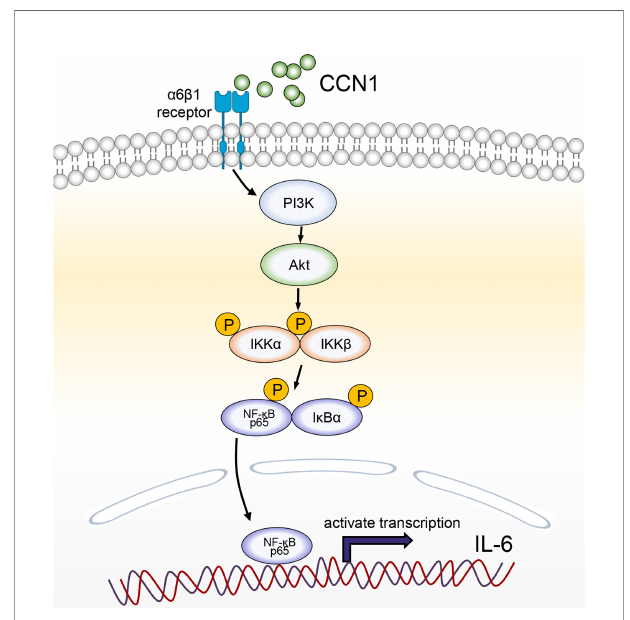
FIGURE 8 | A schematic model for CCN1-stimulated IL-6 production in hepatocytes. CCN1 stimulates IL-6 production via a 6 b 1/PI3K/Akt/NF- k B signaling pathway in